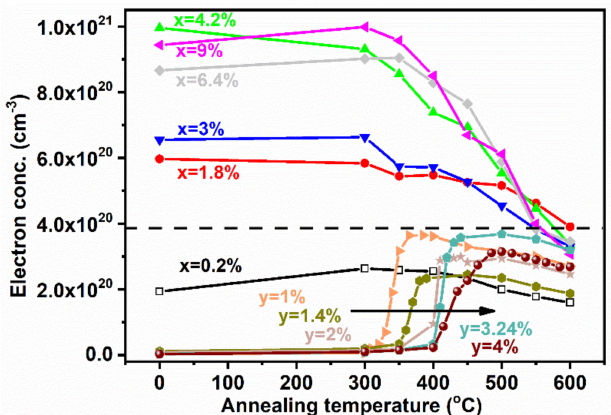
Figure 2. Electron concentrations of Cd 1 − x V x O (x = 0.2~9%) and Cd 1 − y V y O (y = 1~4%) series as a function of annealing temperature when annealed for 20